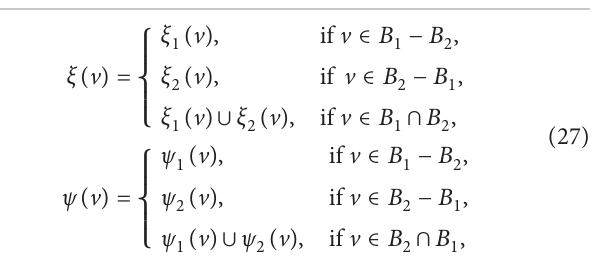
Figure 17. We can see that B ⊂ B ∗ and